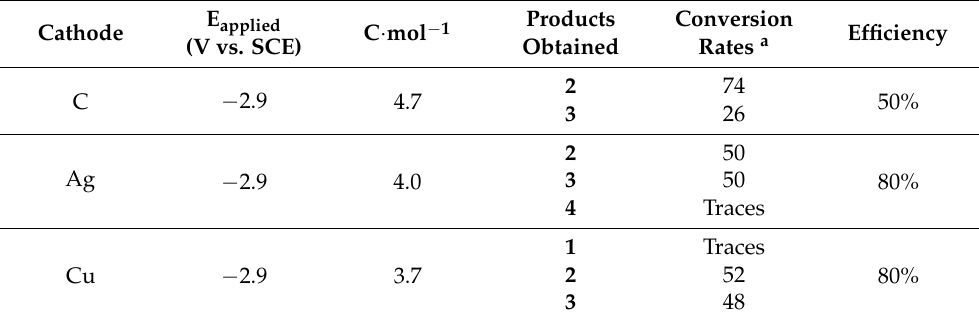
Table 2. Product distribution after control potential electrolysis of 1 in DMF/0.1 M TBA PF 6 with carbon graphite, silver, and copper